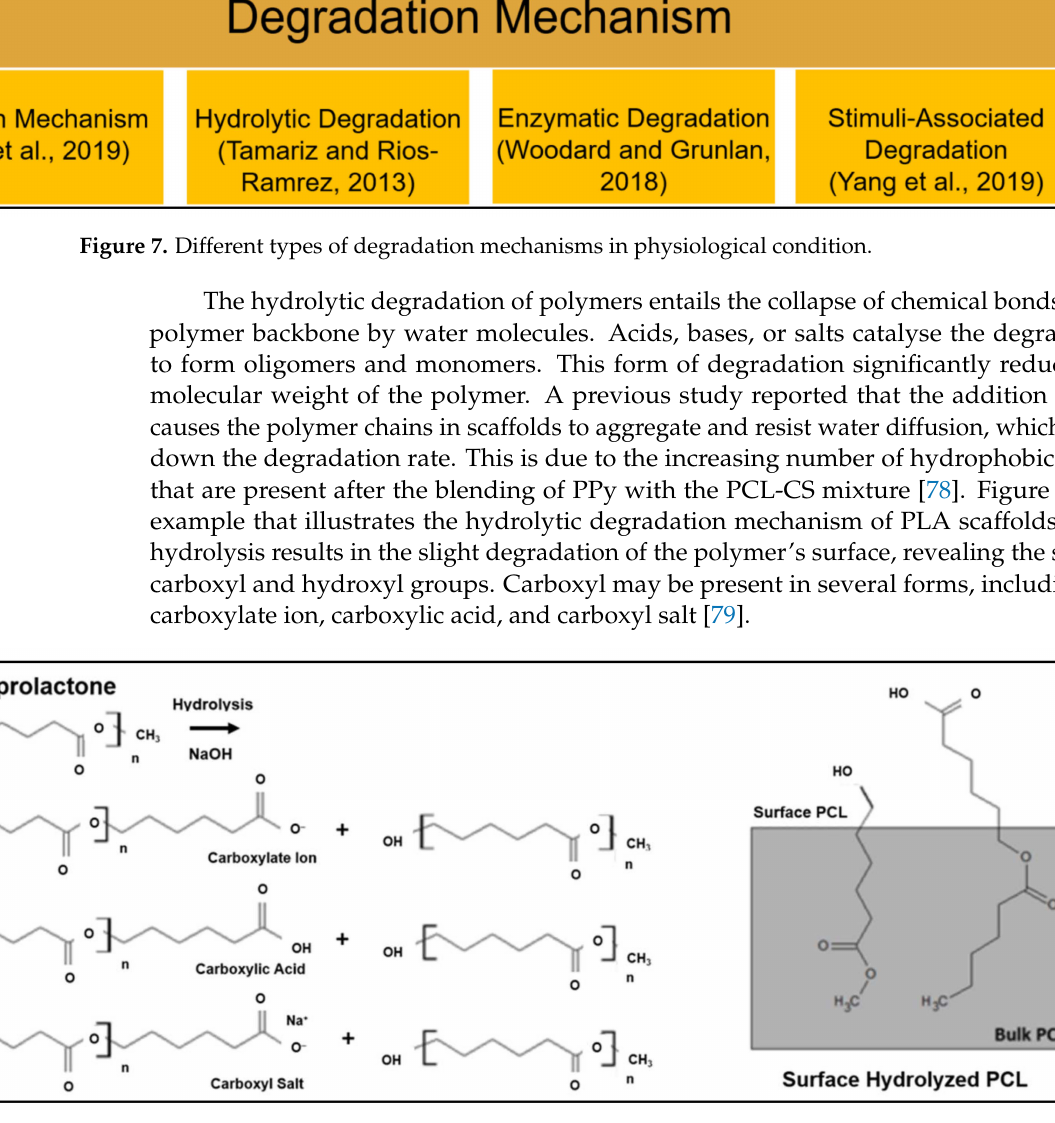
Figure 8. The hydrolytic degradation mechanism of PCL scaffolds [79]. The degradation mechanism process can also be mediated by biological agents, such as enzymes, that partake in tissue remodelling. Polymeric scaffolds are also vulnerable to oxidation mechanisms. When scaffolds are exposed to body fluids and tissues, the host’s immune cells will initiate inflammatory responses. This situation can cause the release of highly reactive oxygenic molecules, such as hydrogen peroxide (H 2 O 2 ), superoxide (O 2 -), nitric oxide (NO), and hypochlorous acid (HOCl). These molecules accelerate polymer chain scission and the degradation of scaffolds. Figure 9 shows an example of the oxidative degradation of poly (urethane) derivatives by hydrogen peroxide compound, including (A) poly(ether urethanes), (B) poly(carbonate urethanes), and (C) aromatic polyurethanes, which produce glycol ether radicals as